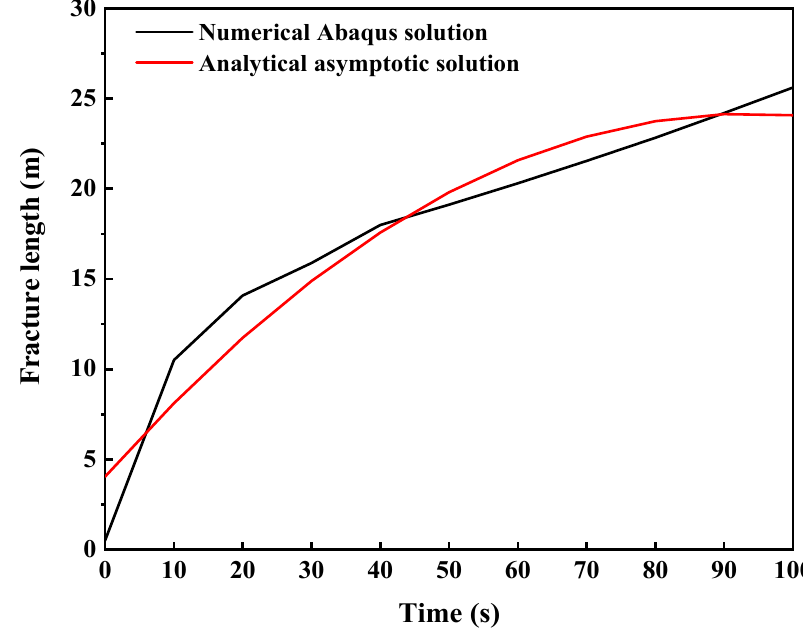
Figure 19. Time evolution of fracture length near the injection point (K vertex).